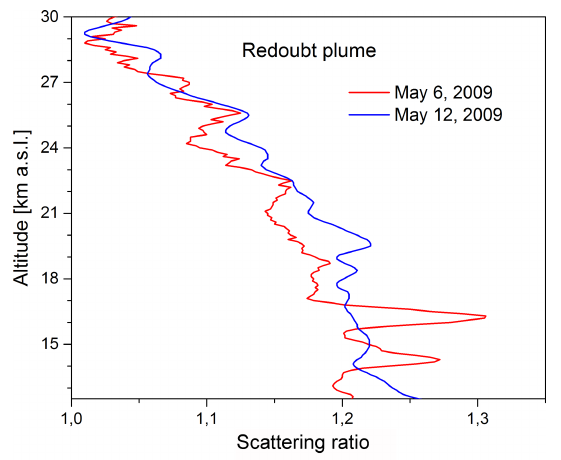
Figure 7. Detection of the Redoubt volcanic plumes in the strato- sphere over Tomsk. The volcano erupted in Alaska from 15 March to 4 April 2009.